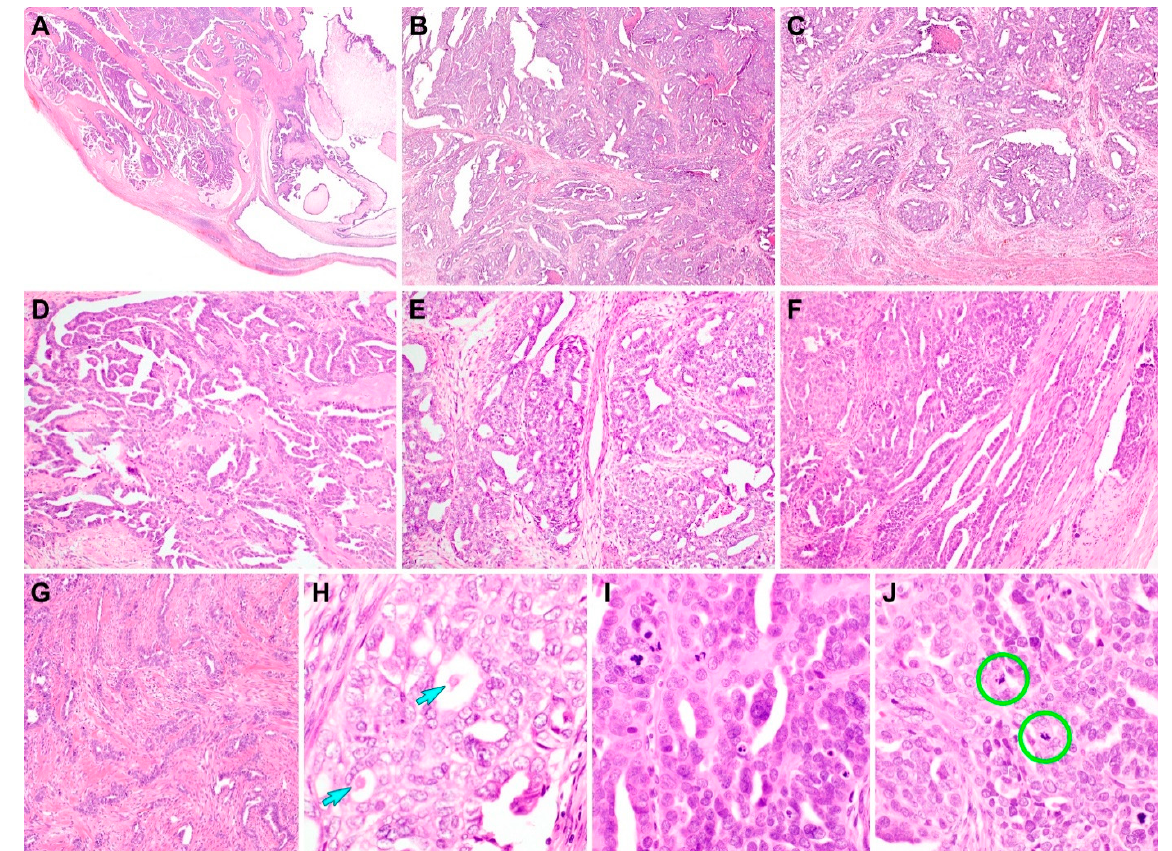
Figure 1. Histological features observed on initial microscopic examination. ( A ) Scanning magnification revealing that the tumor involved the entire myometrial thickness. The irregular glands and cysts contained papillary cellular buds. We considered that the presence of large, cystically dilated spaces was a very uncommon finding if this tumor is endometrial endometrioid adenocarcinoma or serous carcinoma. ( B ) Glandular (left half) and solid (right half) tumor growth patterns resembling grade 2 endometrioid adenocarcinoma of the endometrium. ( C ) At the invasive front, the infiltrating tumor glands accompanied by strong desmoplastic stromal reaction. ( D ) Intraluminal floating papillary tufts and micropapillae morphologically similar to those of serous carcinoma. ( E ) Small tubular and glandular patterns merged into each other and forming a cribriform architecture. The tubules are small, round, uniform, and closely packed; lined with cuboidal-to-low columnar epithelial cells; and accompanied by little intervening stroma, producing a back-to-back appearance. ( F ) In some foci, elongated, slit-like branching tubules lined by flattened epithelial cells and containing papillary tufts (right half; retiform pattern). ( G ) In areas of poorly differentiated carcinoma, the tumor cells with poorly formed, angulated glands, cords, and small nests. ( H ) The nuclei of tumor cells exhibiting tubular and glandular growth patterns show intermediate-grade nuclear atypia, similar to that observed in grade 1 or 2 endometrioid adenocarcinoma. The intraluminal eosinophilic secretions (blue arrows) occasionally observed in tubules and glands. ( I ) Tumor cells growing in solid and papillary patterns displaying moderate-to-severe nuclear pleomorphism and frequent mitotic figures (left upper quadrant) and apoptotic bodies (right lower quadrant). ( J ) Atypical mitotic figures (green circles) are often present. On the basis of the architectural diversity and intraluminal eosinophilic secretions, we initially considered this tumor as mesonephric-like adenocarcinoma. Staining method: A – J , hematoxylin and eosin staining. Original magnification: ( A ) ×10; ( B , C ) ×40; ( D – G ) ×100;